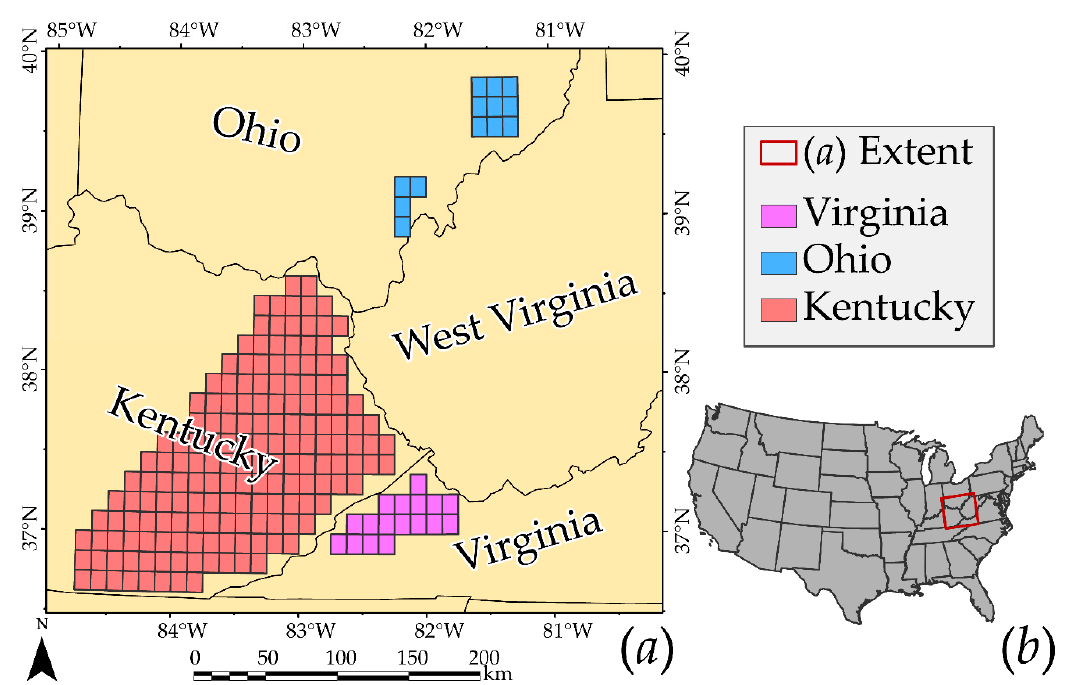
Figure 3. ( a ) 1:24,000-scale, 7.5-minute USGS quadrangle boundaries occurring within the study area extents in Kentucky (KY), Virginia (VA), and Ohio (OH). ( b ) extent of ( a ) within the conterminous US.